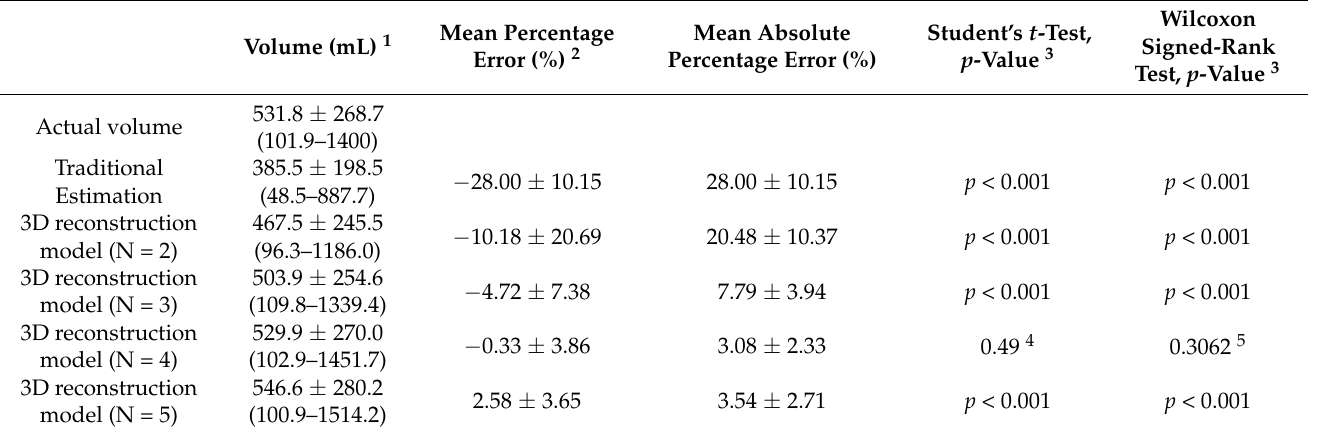
Table 2. Estimated bladder volume and percentage error.